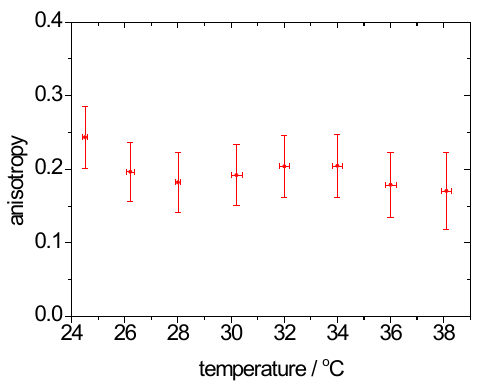
Figure 1. Anisotropy of 1 in pvac as function of